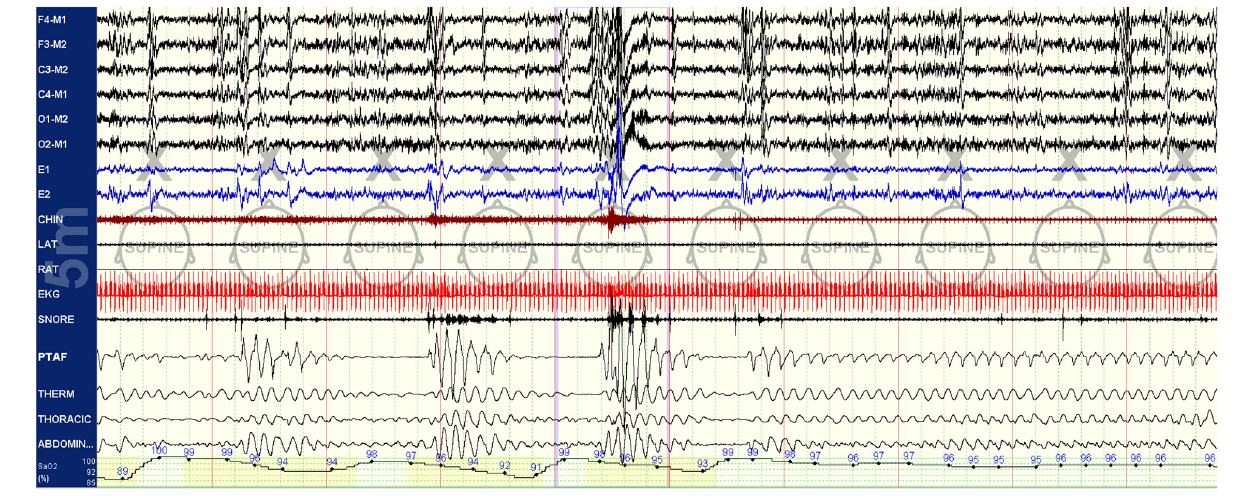
FIGURE 1 | Spontaneous state/respiration switching in NREM sleep. Unstable NREM sleep on the left, spontaneous switch to stable NREM sleep in the middle of this 5-min epoch. EEG montage is standard. LAT, left anterior tibial electromyogram; RAT, right anterior tibial electromyogram; EKG, electrocardiogram; SNORE, snoring microphone; PTAF, pneumotachogram air flow (nasal pressure); THERM, Thermistor airflow; THORACIC, chest effort; and ABDOMIN, abdominal